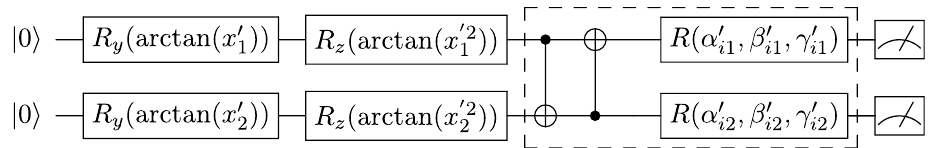
Figure 6. First quantum circuit block for 2D classification. The single-qubit gates R y ( arctan ( x i )) and )) represent rotations along the y -axis and z -axis by the given angle arctan ( x i ) and arctan ( x 2 R z ( arctan ( x 2 i respectively. The state is prepared with variational encoding . The dashed box denotes one layer of a quantum subcircuit that is repeated twice. At the end of this circuit, two qubits are measured, and the Z expectation values are calculated. The output from this circuit is a 2D vector.